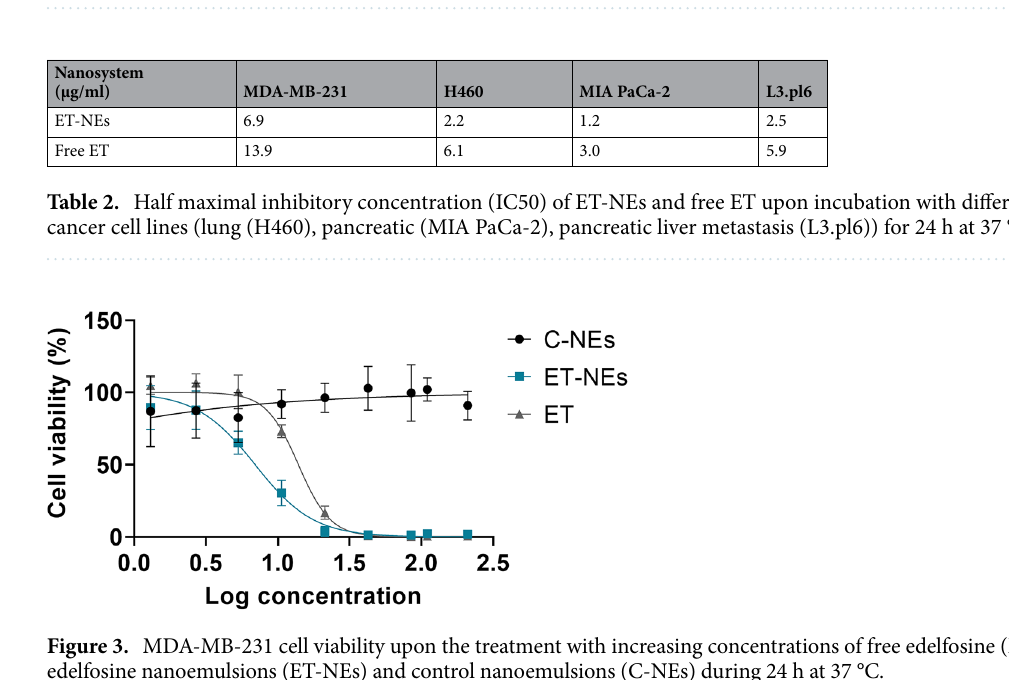
Figure 2. Stability of control NEs (C-NEs) and edelfosine NEs (ET-NEs) upon incubation with zebrafish medium (ZFM, sterile dechlorinated tap water) and cell culture medium (CCM, DMEM supplemented with 1% FBS) for 0, 1 and 4 h, at 37 °C.